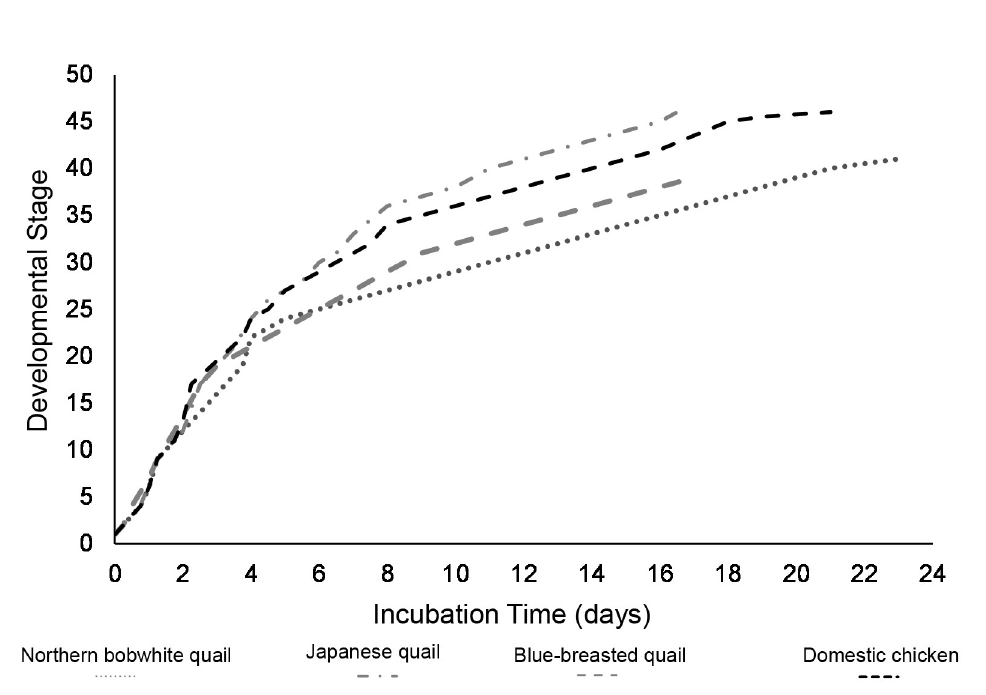
Fig 1. A comparison of embryo age and stages of development between northern bobwhite quail ( Colinus virginianus ), Japanese quail ( Coturnix japonica ), blue-breasted quail ( Synoicus chinensis ), and the domestic chicken ( Gallus gallus domesticus ), during